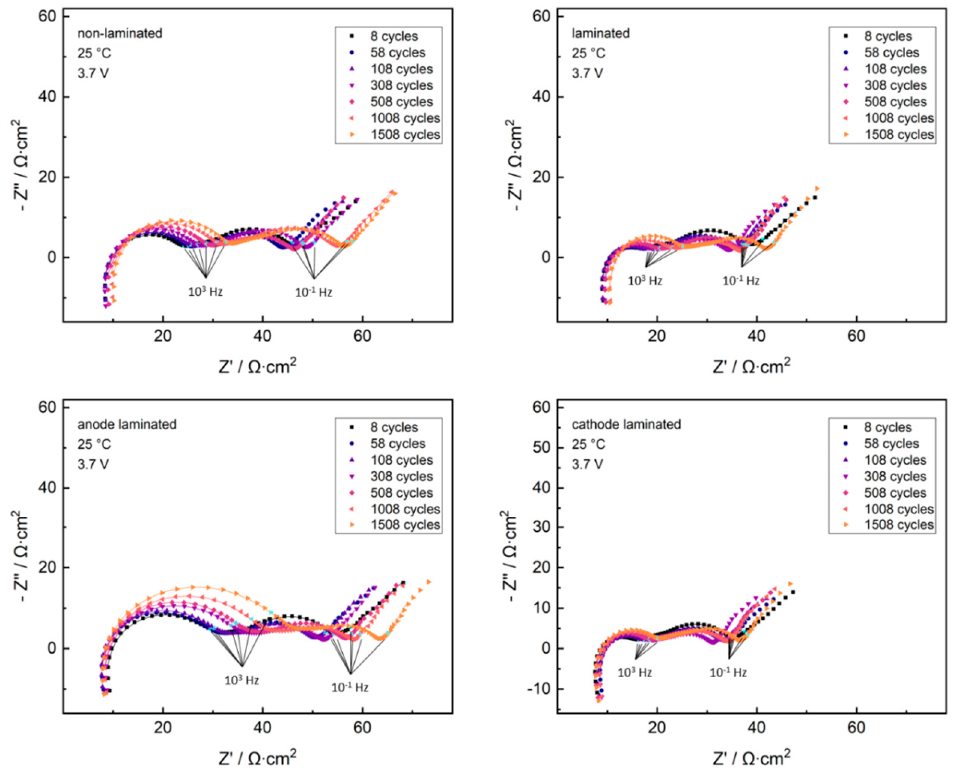
Figure 6. Impedance measurements of laminated / partially laminated / non-laminated cells: EIS (100 kHz – 10 mHz) along fast-charging cycles; fitting curves indicated as solid lines; data points at 10 3 Hz and 10 − 1 Hz highlighted in pale blue.